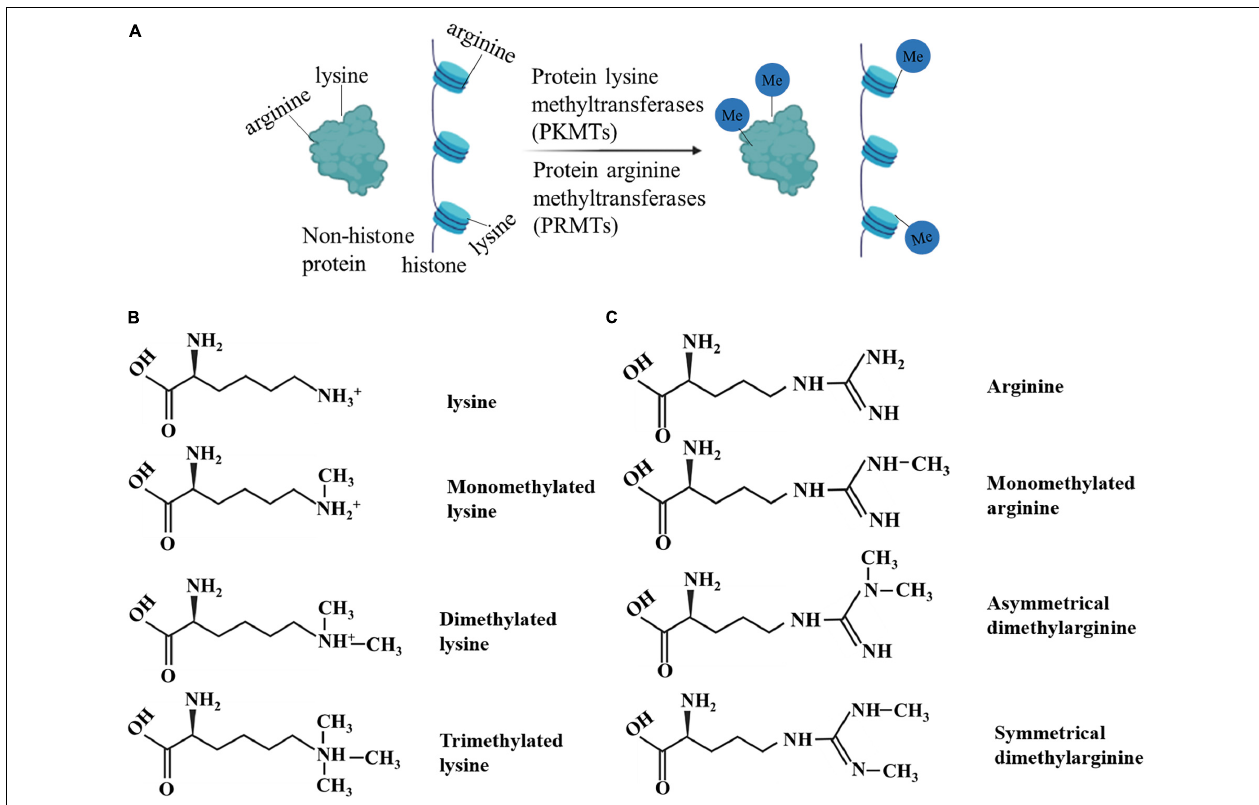
FIGURE 1 | (A–C) Diverse protein